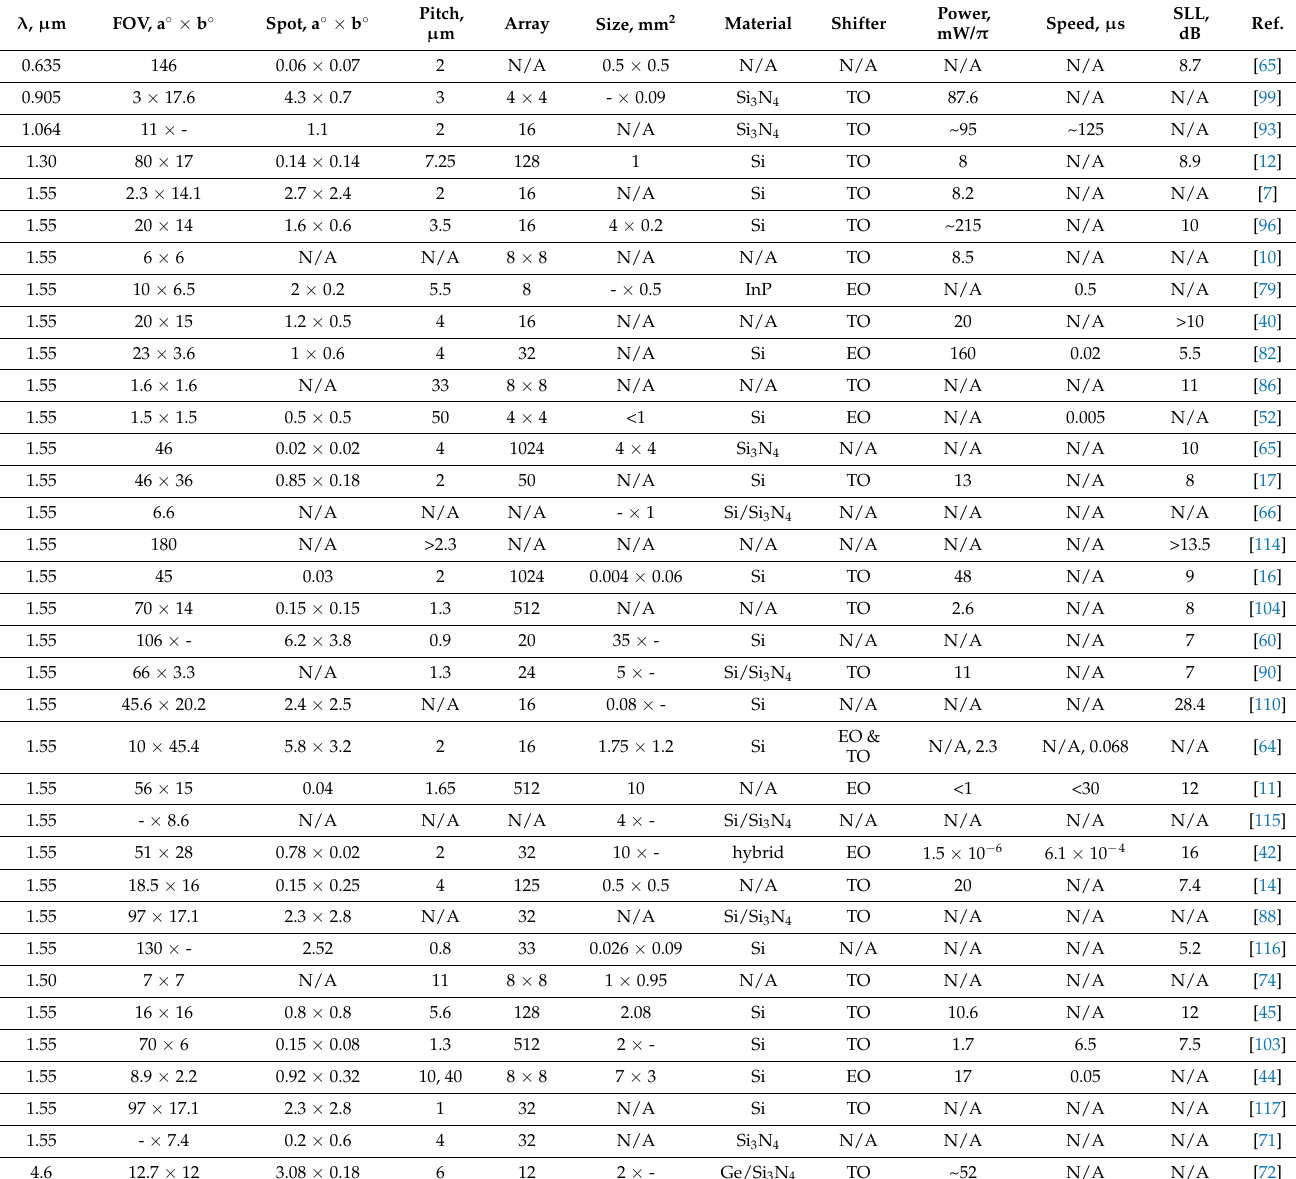
Table 2. Main evaluation parameters of some WGA-based